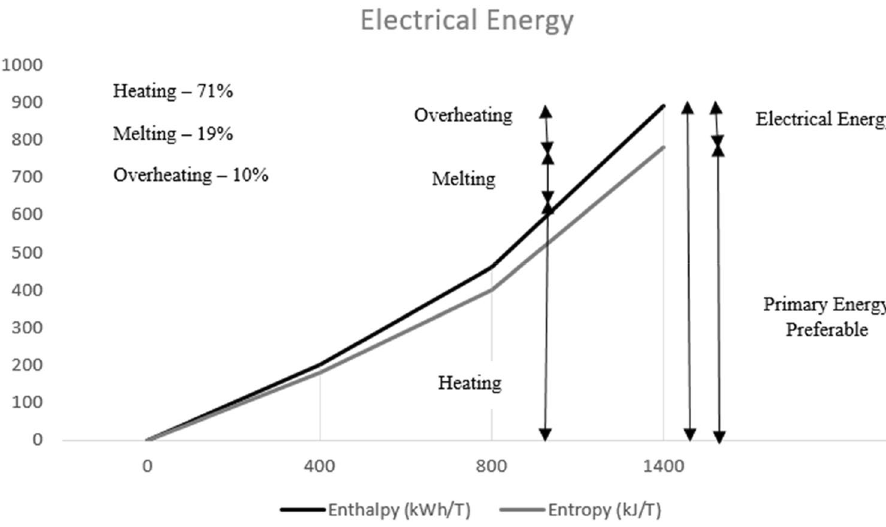
Table 1 Comparison between AC and DC Furnaces [7]